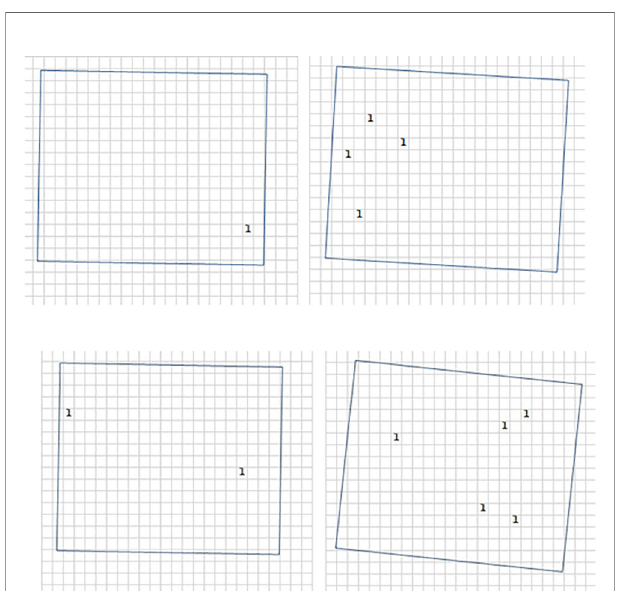
FIGURE 5 | Root distribution in fi eld of view of the Rootsnap sensors for control (B0; top) and biochar 3% (B3; bottom). For counting and registering the position of the roots, an Excel sheet mimicking the nylon mesh (see Figures 4A, B ) was created. The number and position of roots intersecting with the mesh was counted and the time of each penetration of the mesh by a root tip was noted.